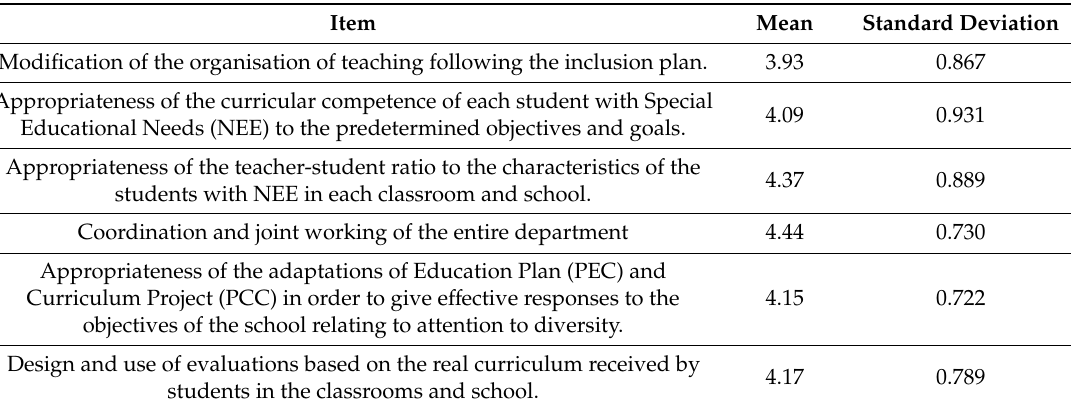
Table 4. Aspects of curricular design.